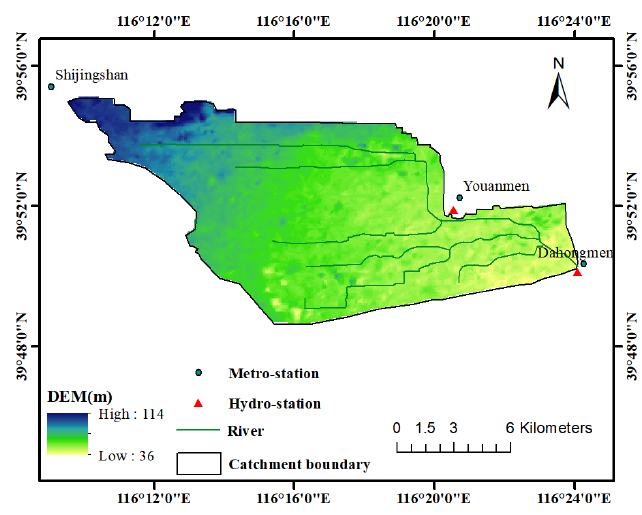
Figure 1. Station distribution at Dahongmen catchment.